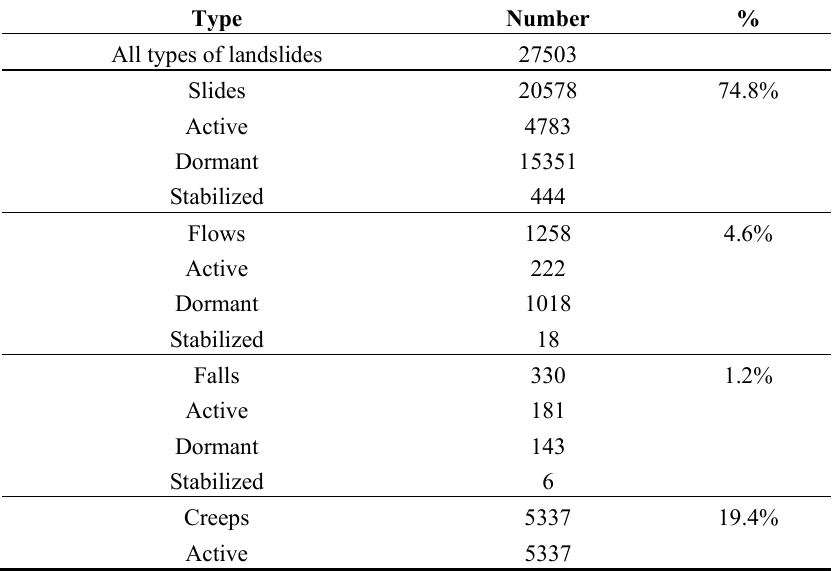
Table 2. The types and numbers of mapped landslides within the Arno River